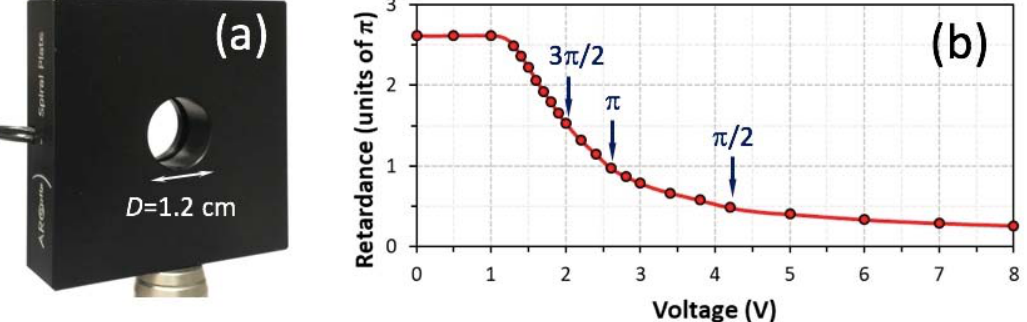
Figure 1. ( a ) Picture of the tunable Arcoptix q-plate. ( b ) Measured optical retardance of the Arcoptix q-plate as a function of the applied voltage for the 633 nm wavelength.